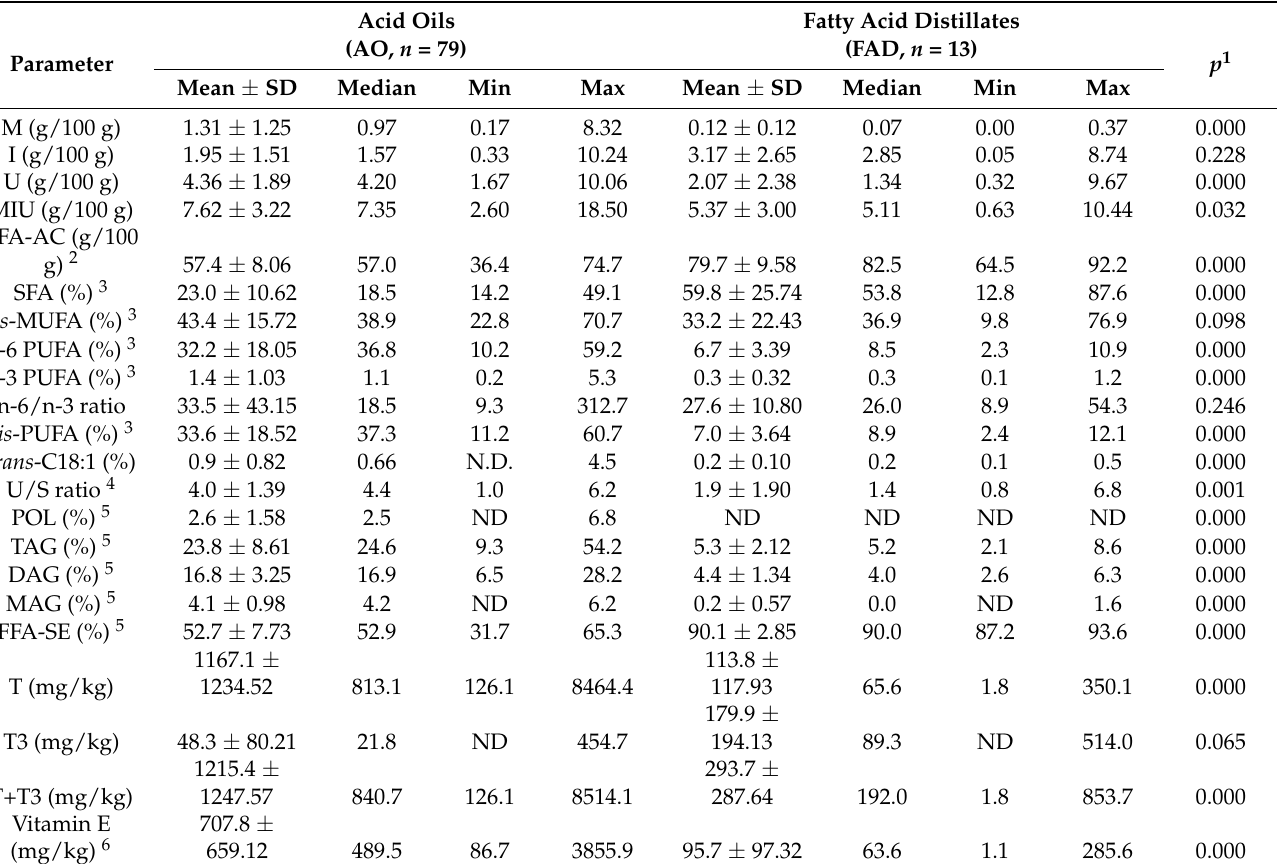
Table 3. Mean, standard deviation, median, minimum, and maximum values obtained for acid oils (AO) and fatty acid distillates